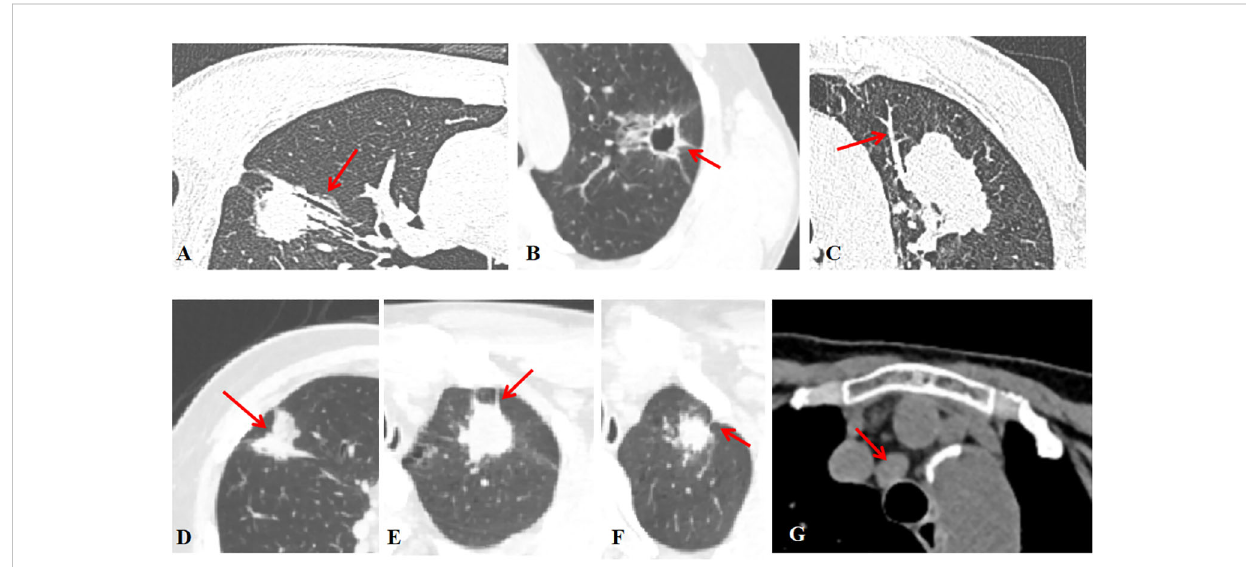
FIGURE 1 Radiographic features (A) The air bronchogram is fl uid- fi lled or solid alveoli surrounded by air- fi lled bronchus. (B) The cavity is a gas- fi lled space >3 mm within a solid lung lesion, mass or nodule. (C) Vessel convergence sign was de fi ned as an increase in internal vessels or clustering of vessels. (D) Lobulation was de fi ned as a nodal margin showing an uneven lobar outline. (E) Spiculation was de fi ned as a small spine-like protrusion from the nodule margin extending into the lung parenchyma without reaching the pleural surface. (F) Pleural indentation was de fi ned as a tapered or linear extension of the lesion into the pleura, re fl ecting pulmonary fi brosis with retraction of the adjacent pleura. (G) Hilar and mediastinal lymph nodes were considered positive if the short axis exceeded 10 mm on chest CT